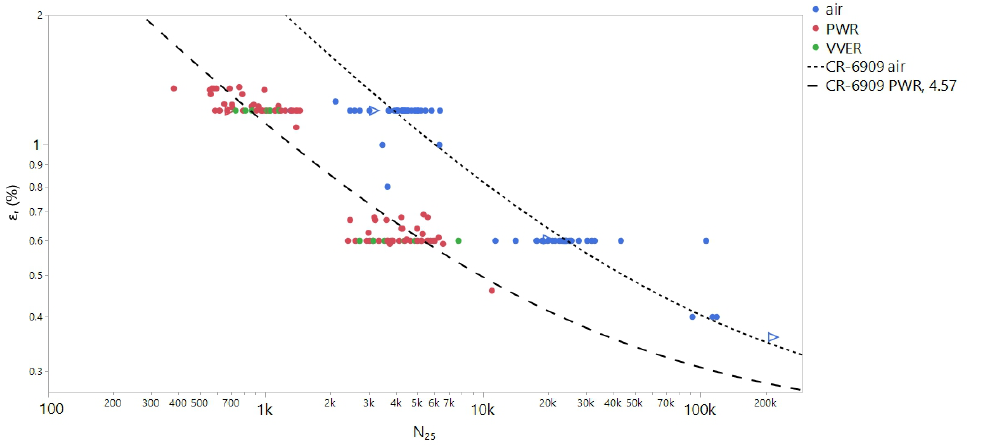
Figure 2. Data from the main programme ( F en = 4.57). The colours refer to the test environment. The (cid:46) indicate runouts, i.e., tests that were stopped before specimen failure (e.g., because of a technical problem with the test